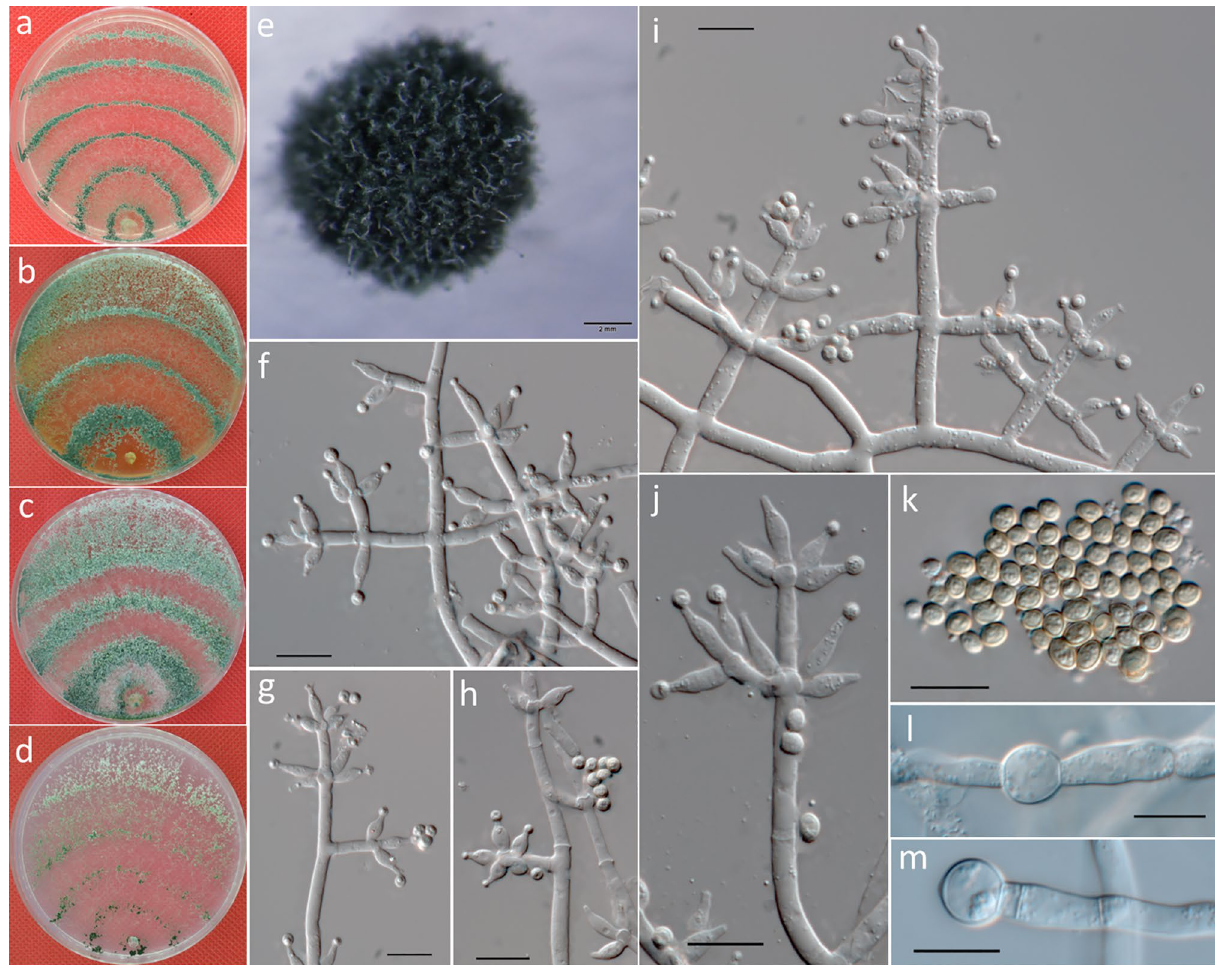
Figure 7. Cultures and asexual morph of Trichoderma harzianum . ( a–d ) Cultures after 7 days at 20 °C [( a ) on CMD; ( b ) on MEA; ( c ) on PDA; and ( d ) on SNA]. ( e ) Conidiation tuft (CMD, 7 days). ( f–j ) Conidiophores and phialides (CMD, 5–7 days). ( k ) Conidia (CMD, 5 days). ( l , m ) Chlamydospores (PDA, 7 days). Scale bars: ( e ) = 2 mm; ( f–m ) = 10